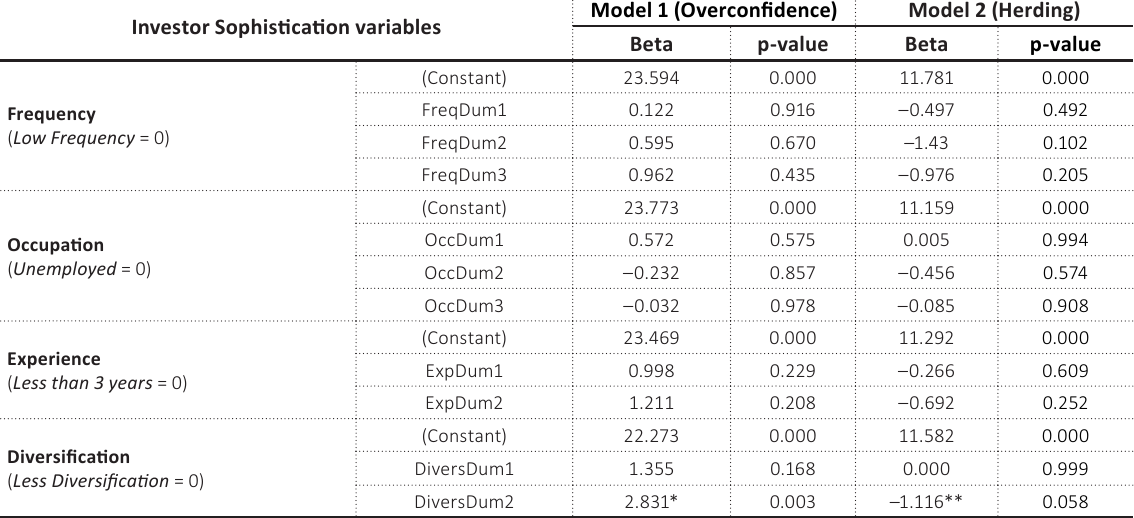
Table 7. Multiple-regression analysis